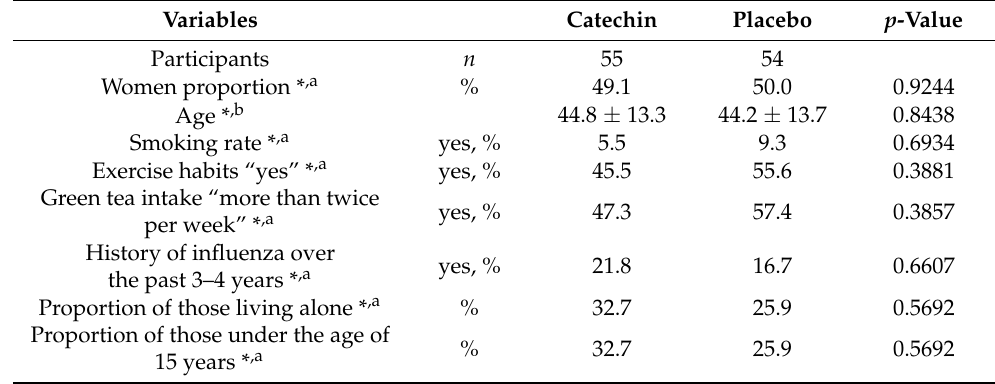
Figure 1. Consolidated standards of trial diagram: enrolment, random assignment, and follow-up of participants. Table 2. Characteristics of participant groups administered either the placebo ( n = 54) or catechin ( n = 55).